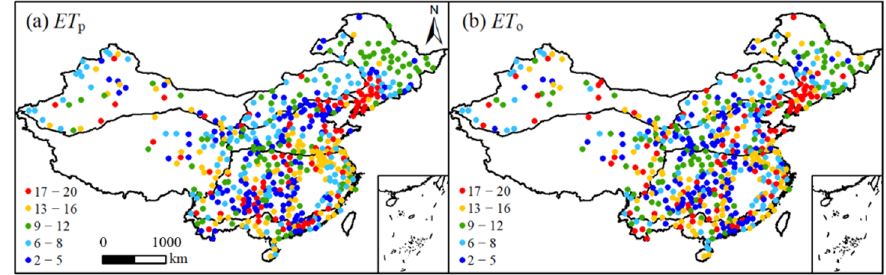
Figure 11. The wavelet spectrum and wavelet variance for the annual ET p ( a ) and ET o ( b ) of mainland China . The thin solid lines denote the cones of influence, and the thick solid lines show the 95% confidence levels. The color bar represents the vibration intensity of the periods at different timescales.